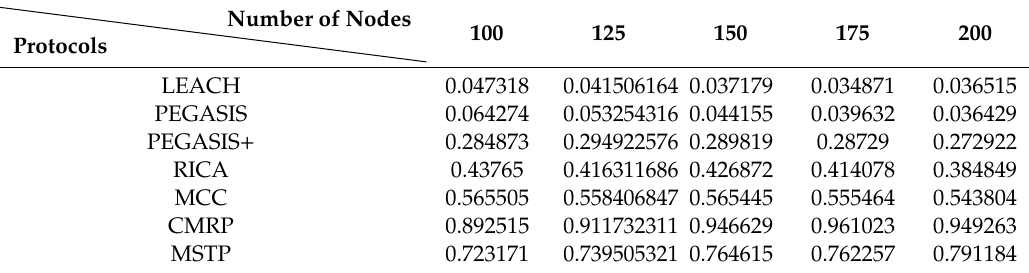
Table 1. LDR value of the evaluated